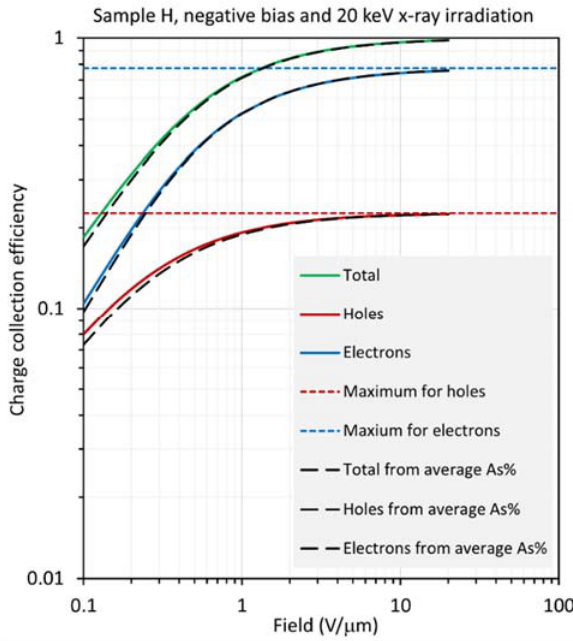
Figure 9. Log–log plot of the CE as a function of field for sample H (near optimum), biased negatively and exposed to X-rays with a photon energy of 20 keV, so that δ / L =0.243. When the calculations are repeated for X-rays with a photon energy of 30 keV, even better agreement was observed between the actual CE and that from the average composition. This is not unexpected, since the carriers are generated within ~0.73 L , that is, more of the volume around the mean composition ( x = 0.445 L ) of the film is used. One can therefore conclude that, for a-Se films with a slowly varying As composition across the film thickness, it is sufficient to use the carrier ranges r h av and r e av , corresponding to ranges at C , to calculate the CE based on Equation (4).